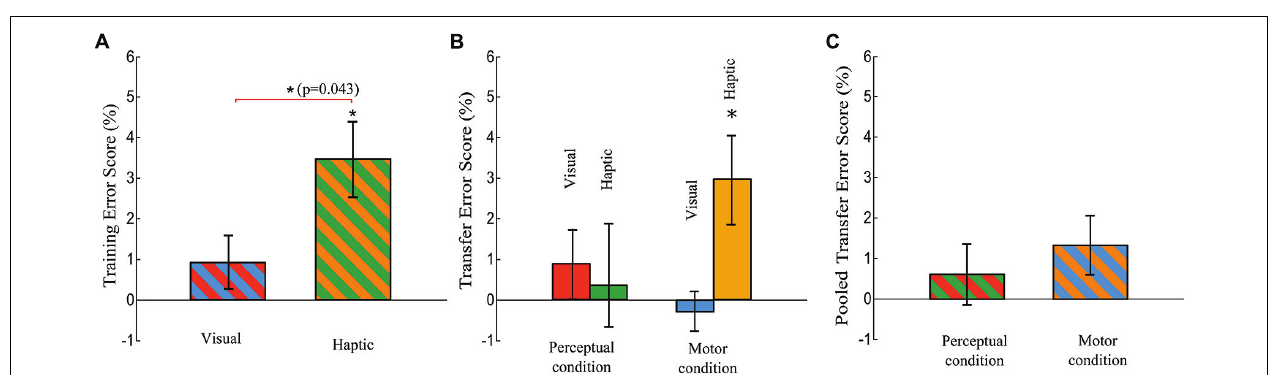
FIGURE 5 | Training RT Score and Transfer RT Score. The Training RT Score is defined as a difference in RT between the means of blocks 8 and 10 and block 9, and the Transfer RT score is defined as a difference in RT between the means of blocks 12 and 14 and block 13. (A) Training RT Scores of the visual and haptic groups (no differences in the cues presented to the subgroups in the training phase). (B) Transfer RT Score of the visual-perceptual, haptic-perceptual, visual-motor, and